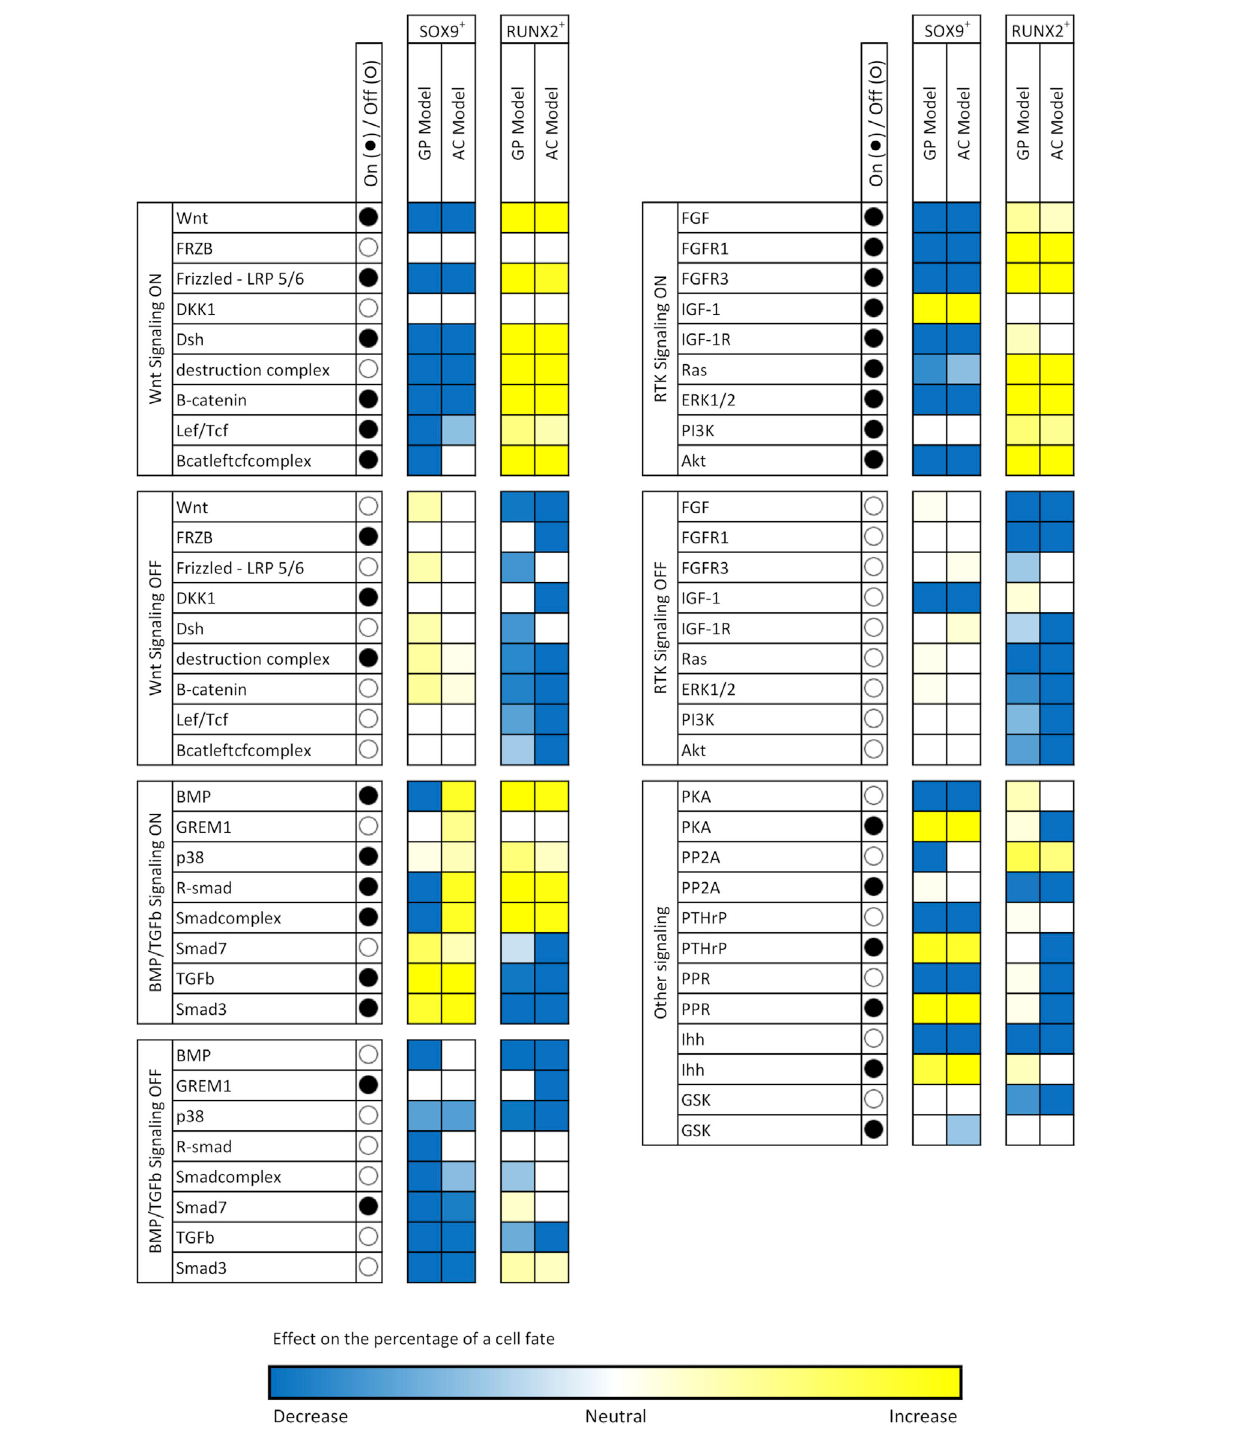
FIGURE 3 | Effects of node perturbations on cell fate. Each node in ECHO was set as either constitutively active (activity fi xed at 100, C ) or knocked-out (activity fi xedat0, ○ ),whileallothernodeswererandomlyinitializedoverthecourseof10,000simulations.Theresultingpercentagesofcellfateswerecomputed andcompared withthepercentagesinTableX1.Thecolorsthecellsinthistableshowthemagnitudeofdeviationfromthenon-perturbedvaluesandgiveanindicationoftheimportance of a node for a cell fate.